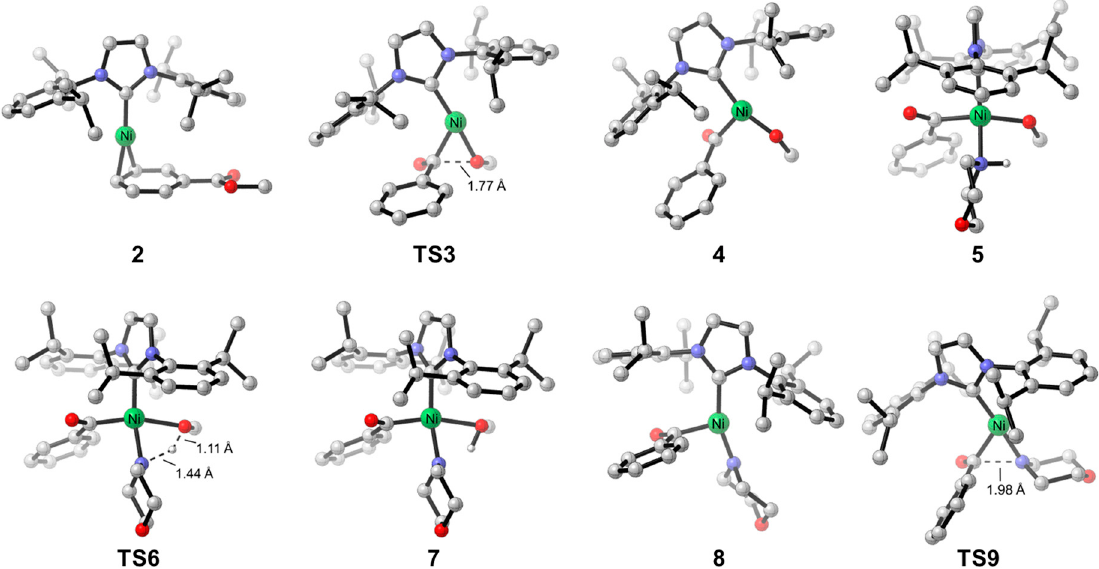
Figure 2. Optimized structures of selected intermediates and transition states in the catalytic cycle of Ni/IPr-catalyzed amidation of ester.